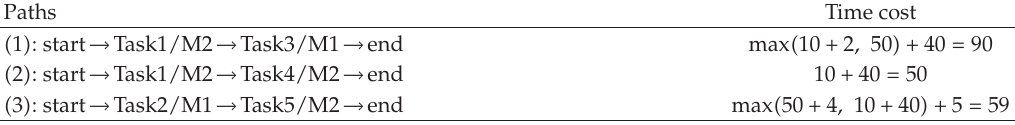
Paths Time cost (cid:3) 1 (cid:4) : start → Task1/M2 → Task3/M1 → end